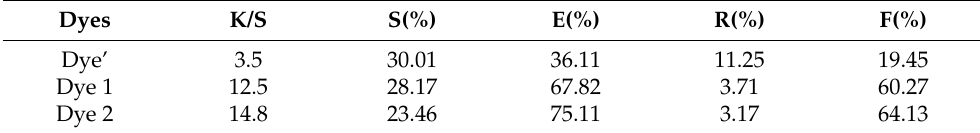
Table 1. Color strength (K/S) and characteristic values (SERF) of the synthesized dyes.